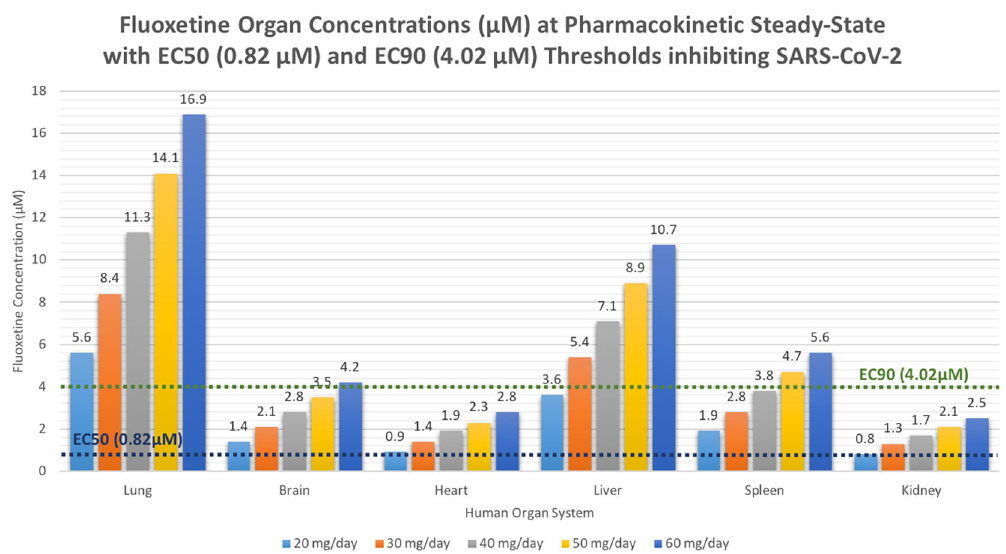
Figure 8. Fluoxetine median organ concentrations ( μ M) at pharmacokinetic steady-state with EC50 (0.82 μ M) and EC90 (4.02 μ M) thresholds known to inhibit